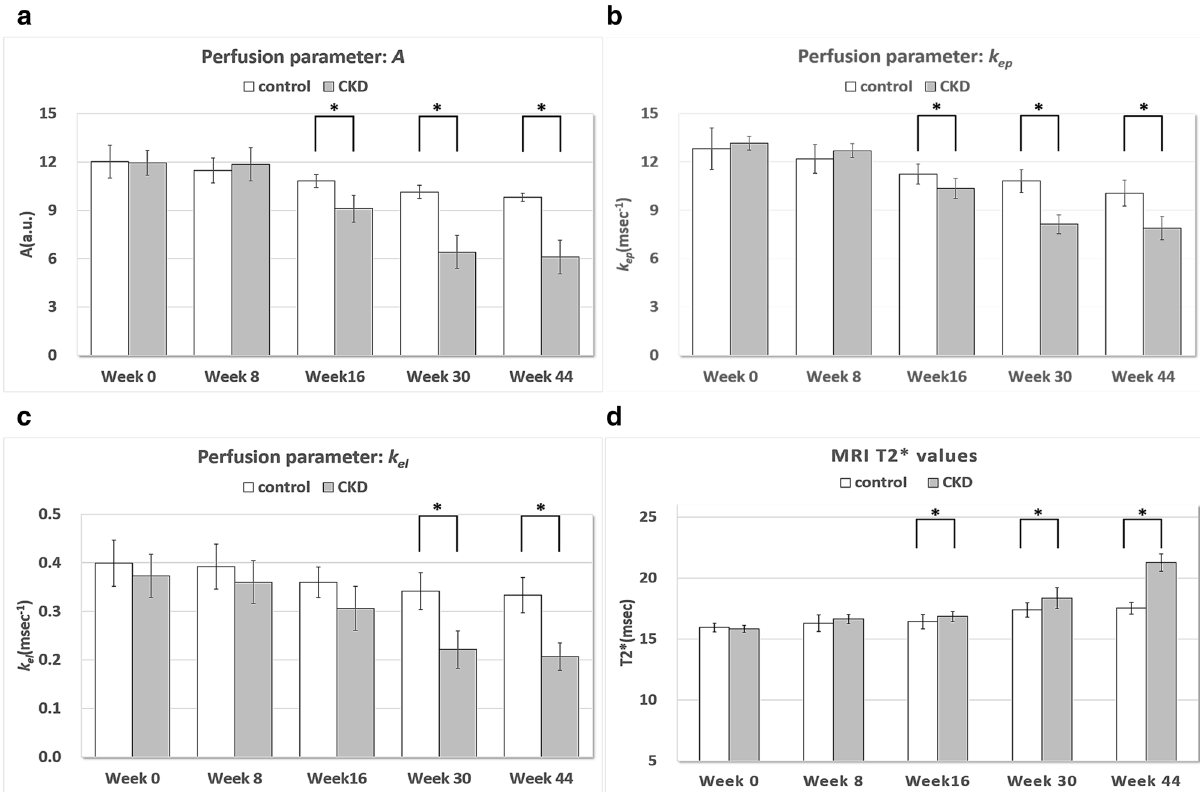
Figure 1. Bar charts showing the three perfusion parameters and MRI T2* values for IPFP of the control and CKD groups. The perfusion parameters ( a ) A (unit: a.u.), ( b ) k ep (unit: min −1 ), and ( c ) k el (unit: min −1 ) and the MRI T2* value ( d ) were measured in all rats at weeks 0, 8, 16, 30, and 44. Asterisks indicate significant differences ( p < 0.05). Regarding ( a ) and ( b ) respectively perfusion parameters A (blood volume) and k ep (permeability), significantly decreasing values can be found from week 16 to 44 in the CKD group. Regarding wash out parameter k